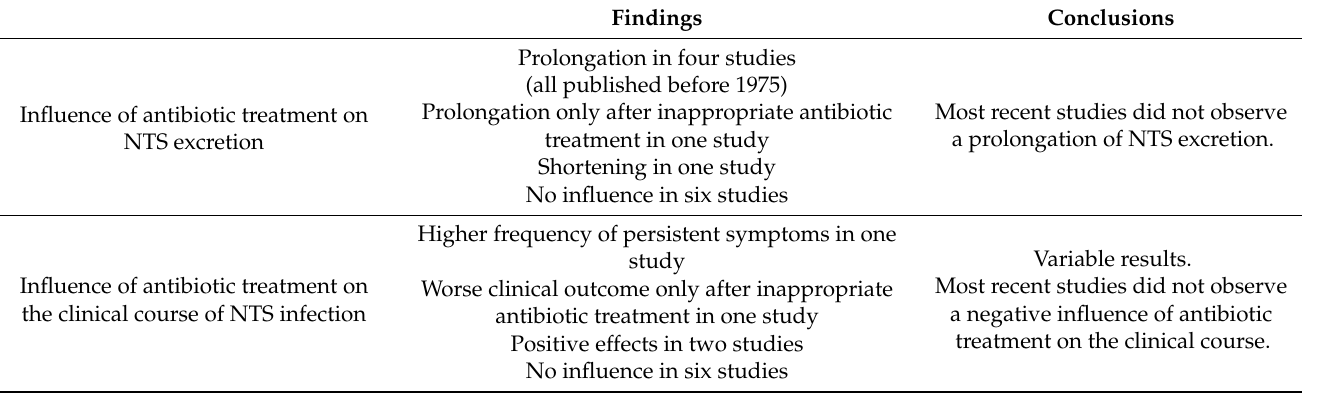
Table 2. Summary of the findings of this systematic